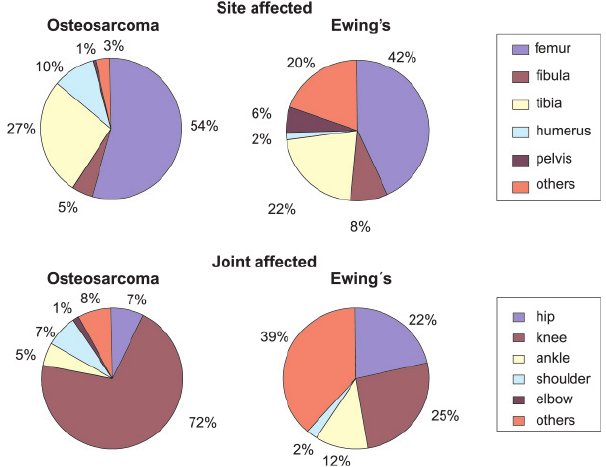
Figure 3 - Absolute and relative frequency distribution of bone sites and joints affected by tumor in patients with Osteosarcoma and Ewing’s